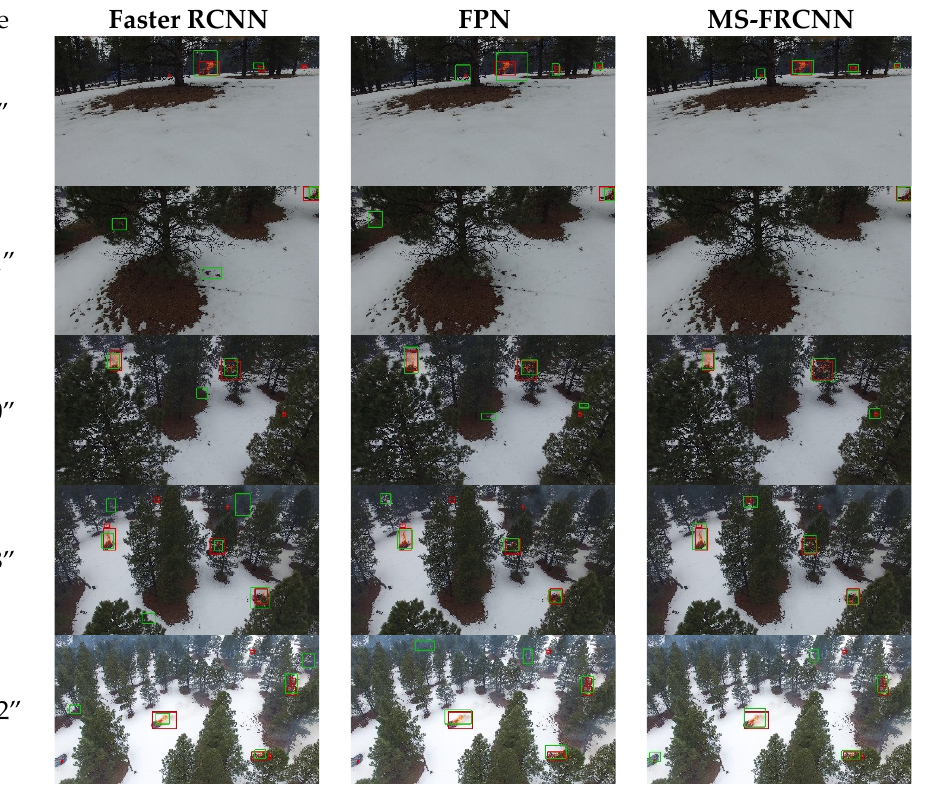
Figure 11. Examples of the visualized results of the detection of small target forest fire images in each model.